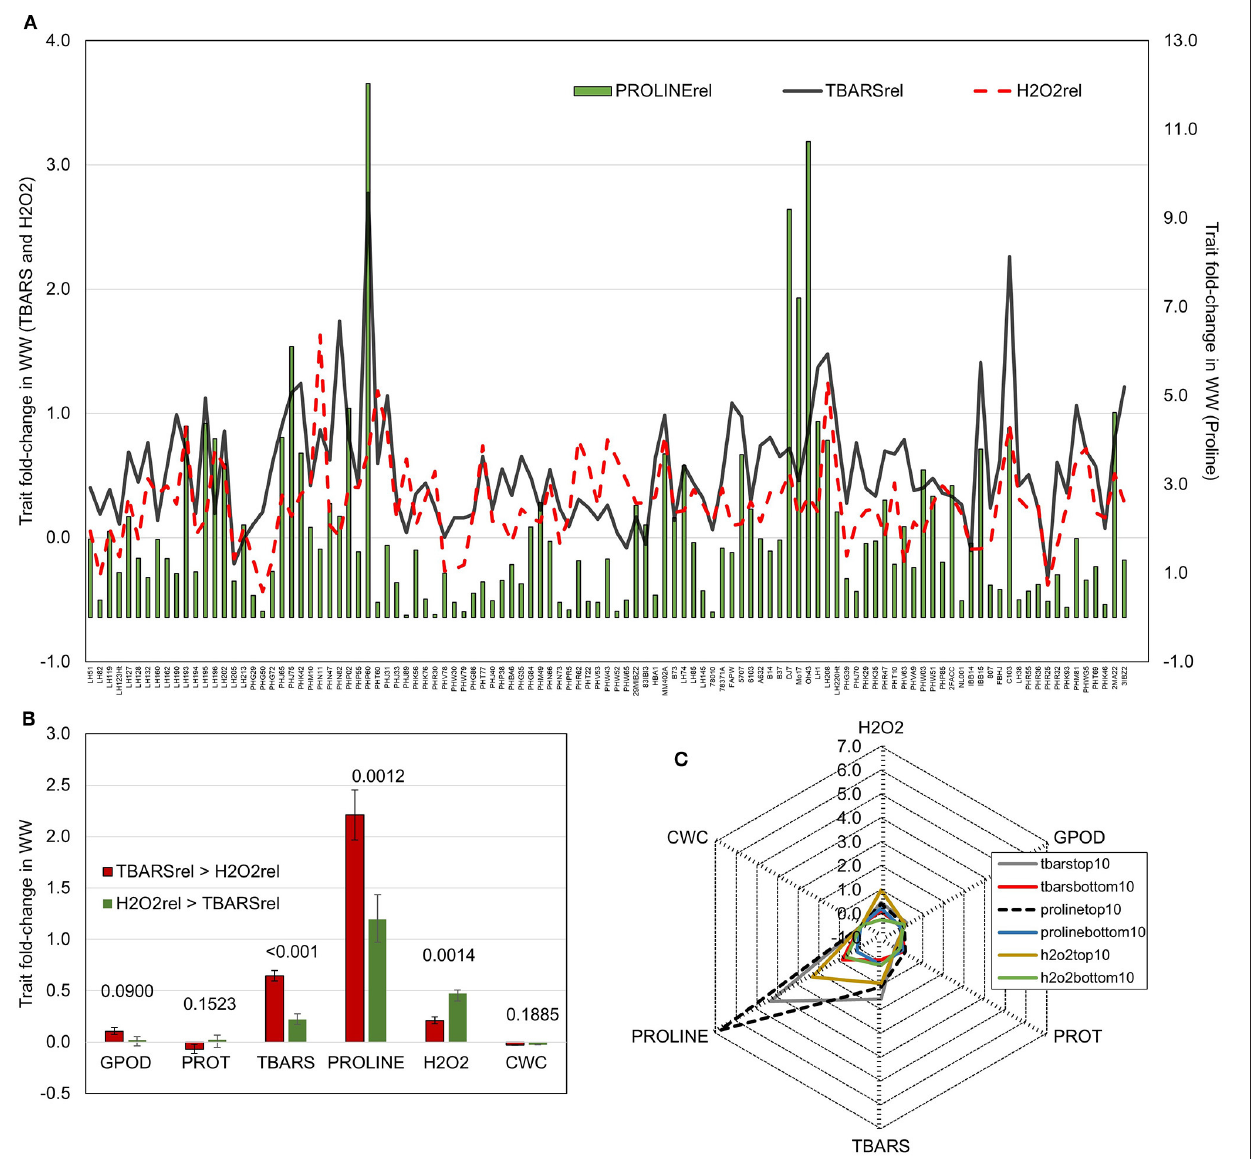
FIGURE 2 | (A) Fold-change in WW compared to CO of TBARS and H 2 O 2 accumulation (left y-axis) and proline (right y-axis); (B) Fold changes in WW compared to CO of GPOD, PROT, TBARS, proline, H 2 O 2 , and CWC in groups with larger fold change of TBARS than H 2 O 2 (TBARS > H 2 O 2 ) and with larger fold change of H 2 O 2 than TBARS (H 2 O 2 > TBARS). p -values of pairwise t -tests between groups are given above bars; (C) radar-plots of fold changes WW compared to CO of GPOD, PROT, TBARS, proline, H 2 O 2 , and CWC in top and bottom 10 performers in fold change of TBARS, proline, and H 2 O 2 .